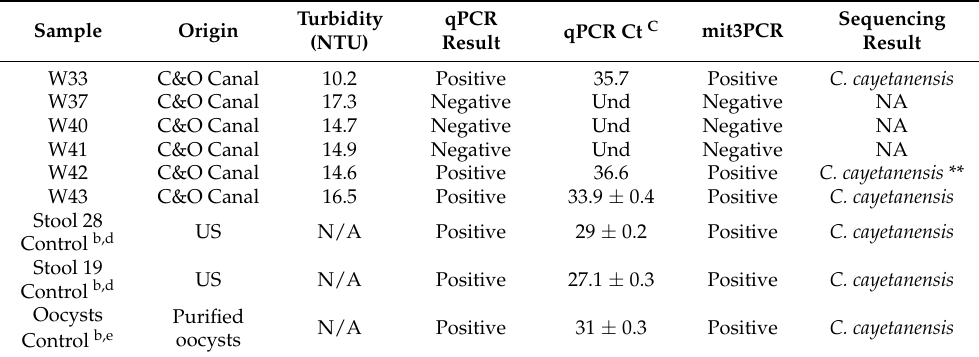
Table adapted from Durigan et al., 2020 [25] with new data added. b DNA extracted from clinical samples positive for C. cayetanensis and purified oocysts were included for comparison. C No SD is shown when only one replicate produced a positive result. d Stools 19 and 28 represent DNA from clinical samples from two individuals positive for C. cayetanensis by microscopic and molecular analysis. e Oocysts control represents DNA from oocysts purified from stool from an Indonesian patient. ** The complete fragment (182 bp) was not